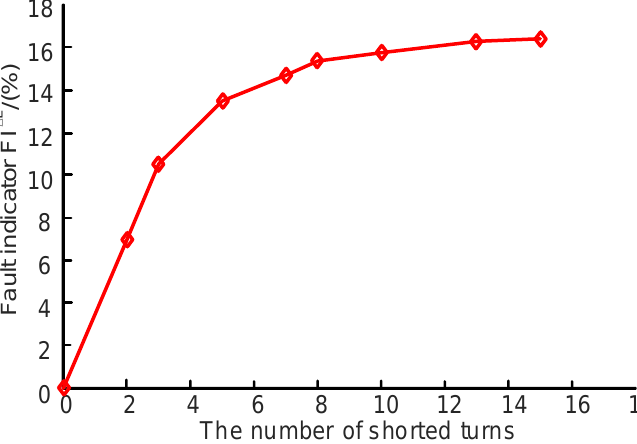
Figure 10. FI ∆ L under different numbers of shorted turns. In summary, when the stator fault occurs in phase A, the line-to-line resistances R AB , R CA and the inductances L eq , L eq increase with the number of the shorted turns, whereas AB CA the R BC and L eq are almost unchanged, which is in agreement with the proposed algorithm BC in this paper. Correspondingly, the resistance fault indicators FI R and FI degrees of change, which can be adopted to detect the stator fault and locate the fault